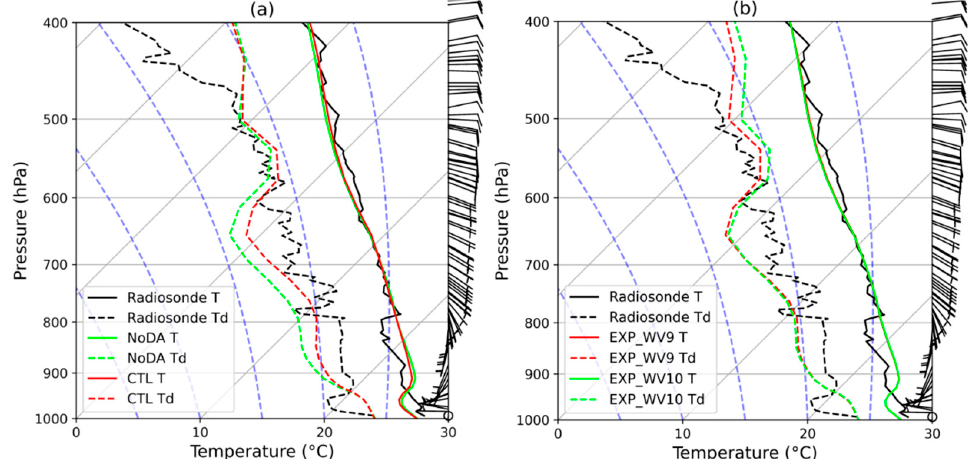
Figure 11. Skew-T diagram showing temperature ( T ) and dew point temperature ( T d ) profiles of ( a ) the radiosonde, NoDA, and CTL, ( b ) the radiosonde, EXP_WV9, and EXP_WV10 at the location of (118.1°E, 24.5°N) at 0000 UTC on 5 July 2020.